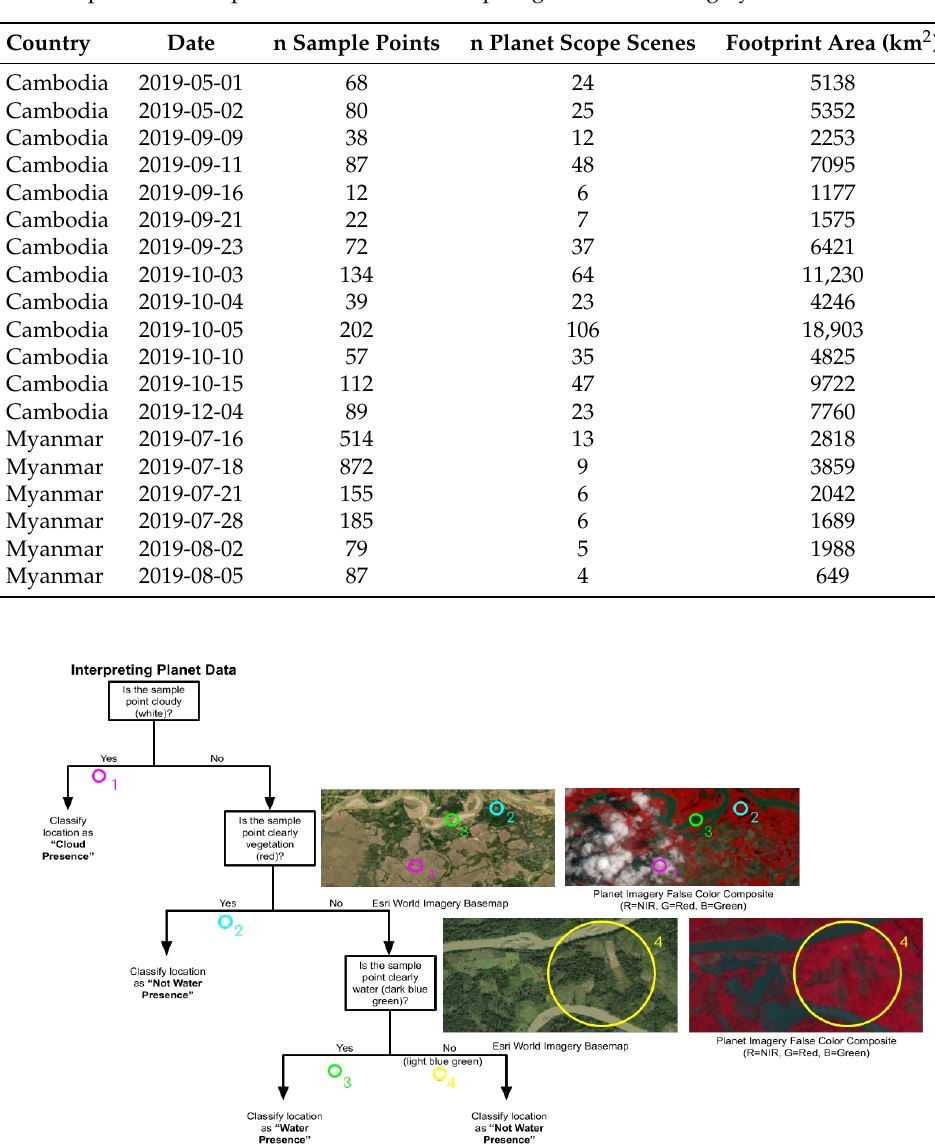
Table 1. Spatial and temporal extent of Planet Scope high resolution imagery used for evaluation.